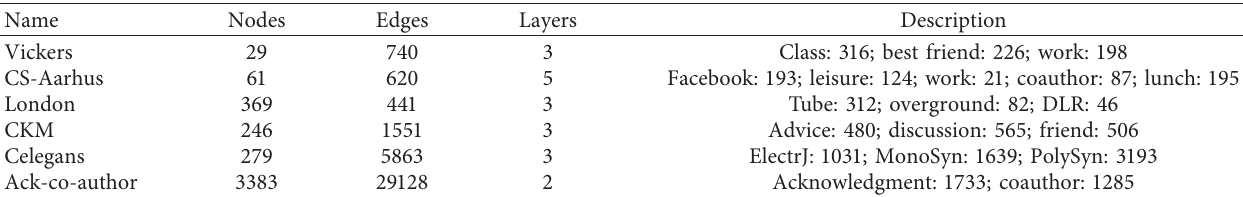
Table 2: Basic statistics about different multiplex networks used in this